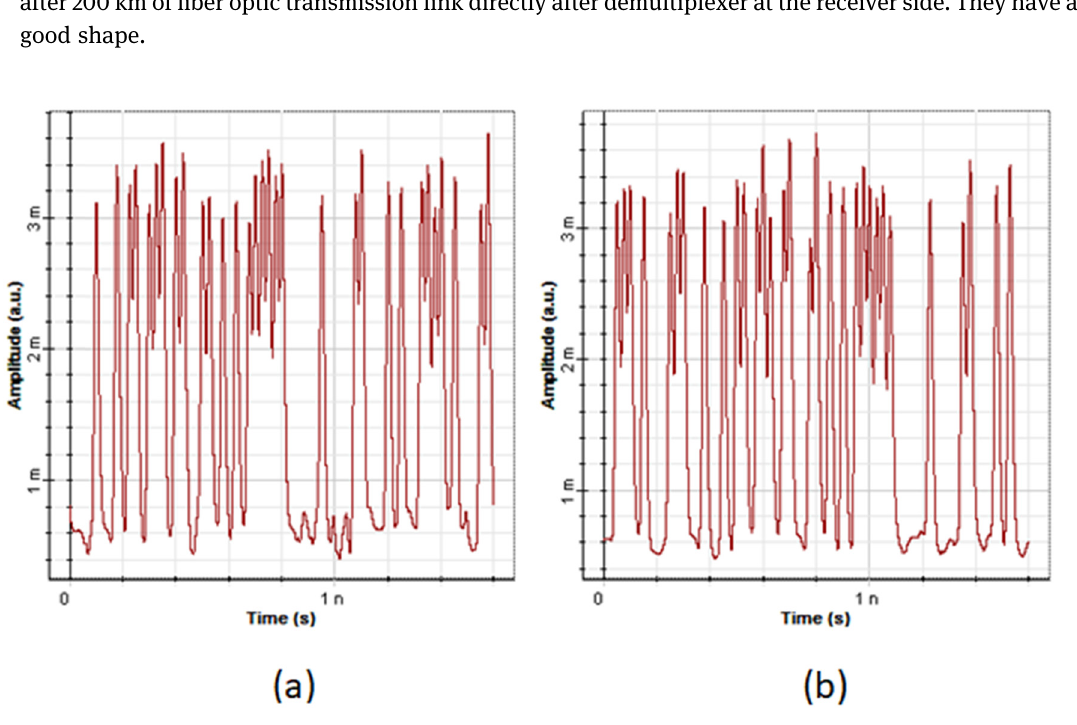
Figure 8: Amplitude vs time directly after Photodetector ( PIN ) at the side receiver for output add: ( a ) signal_1 = 193.1 THz and ( b ) signal_4 = 193.4 THz @span = 200 km, and bitrate = 40 Gbps.